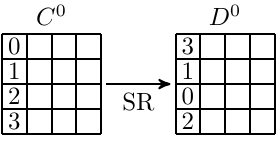
Figure 4: Illustration of the column ordering